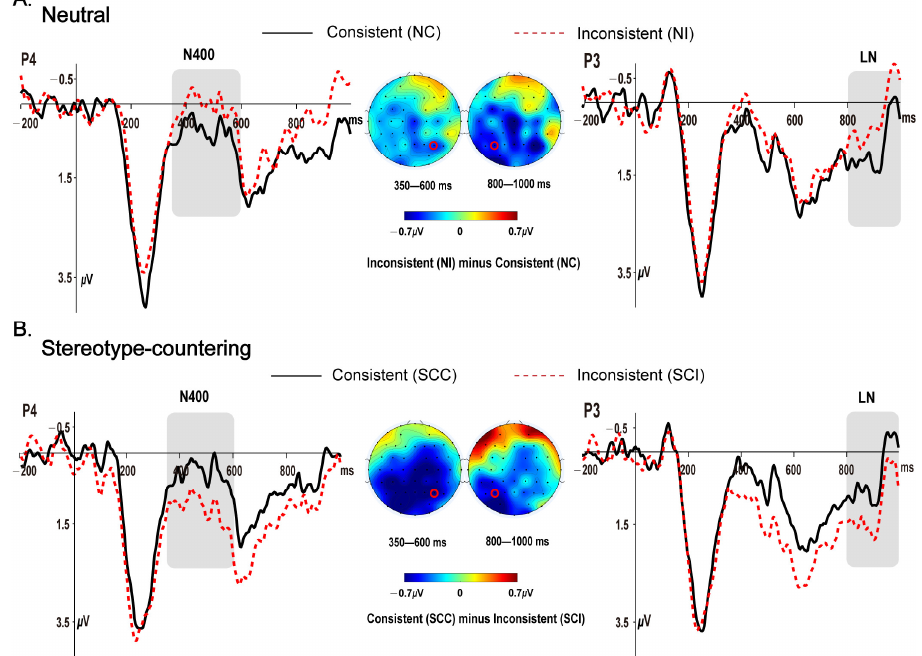
Figure 1. ERPs time locked to the onset of the critical words. Grand average ERPs for the consistent and inconsistent conditions at electrodes P4 (left side of the figure) and P3 (right side of the figure) in the neutral ( A ) and stereotype-countering discourse contexts ( B ), respectively, together with the scalp topographies of the corresponding difference waves (left and right red circles indicate electrodes P4 and P3, respectively; note that the difference waves in ( B ) were obtained by subtracting the inconsistent from the consistent conditions).